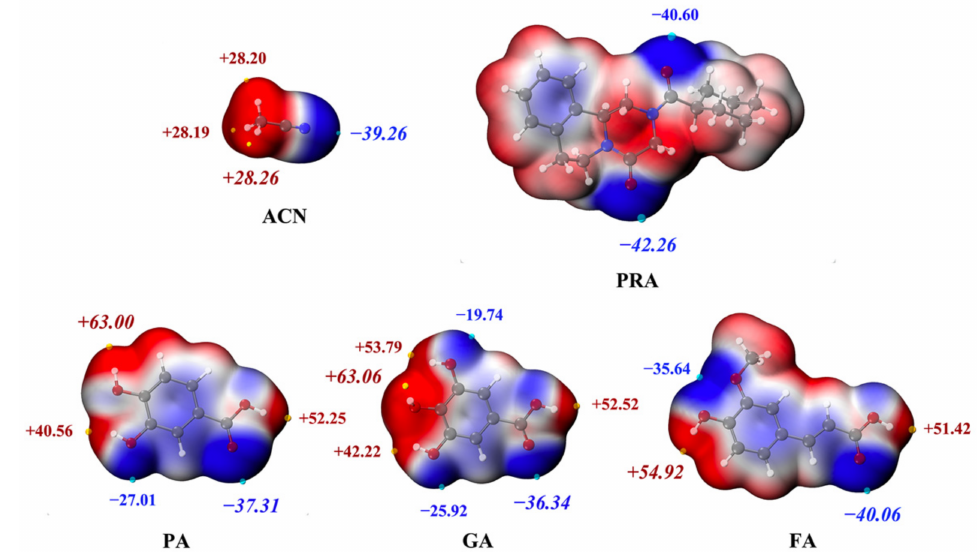
Figure 8. The MEPS maps of API, CCFs and solvent. Red represents the positive potential, and blue represents negative potential; the unit is